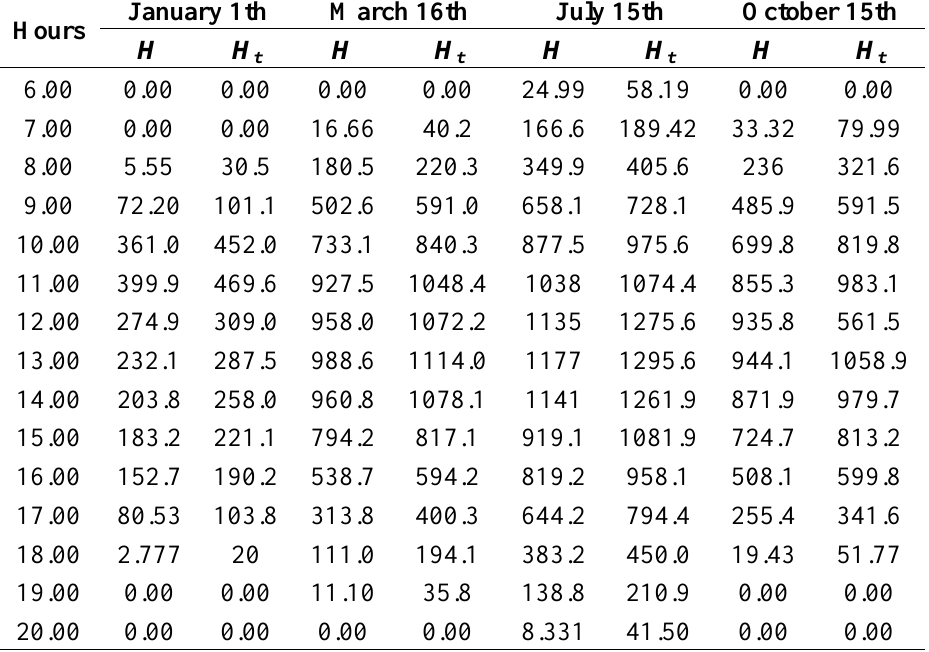
Table 3. Measured global irradiation on an inclined and horizontal surface by W/m 2 for